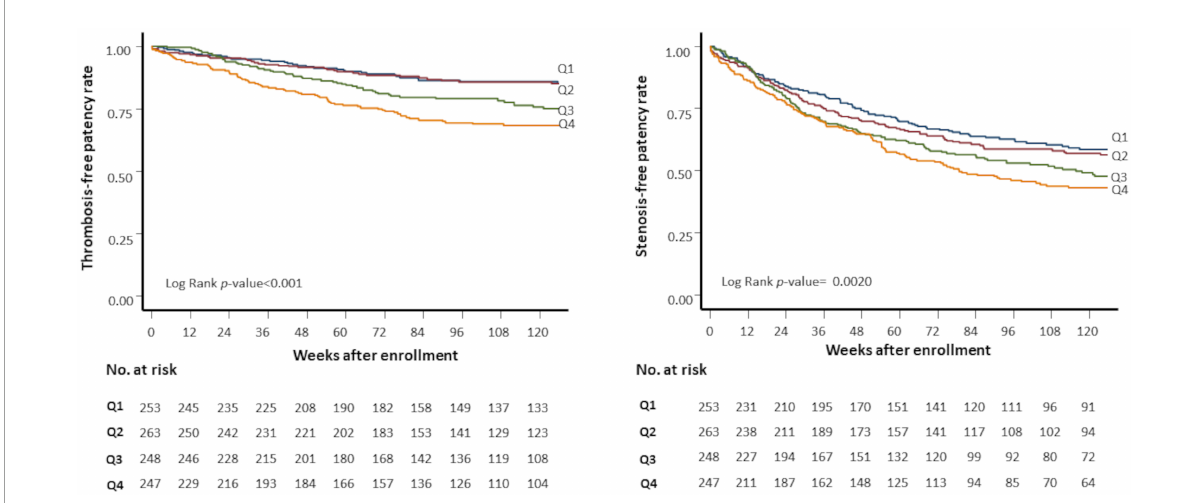
FIGURE2 Kaplan-Meier plots of vascular access outcomes. Kaplan-Meier plots of stenosis-free patency (left panel) and thrombosis-free patency (right panel) rates by quartiles of predialysis systolic blood pressure variability (SBPV). Q1 (blue line), first (lowest) SBPV quartile; Q2 (red line), second quartile; Q3 (green line), third quartile; Q4 (yellow line), fourth (highest) SBPV quartile. No. at risk, the number of patients at risk.